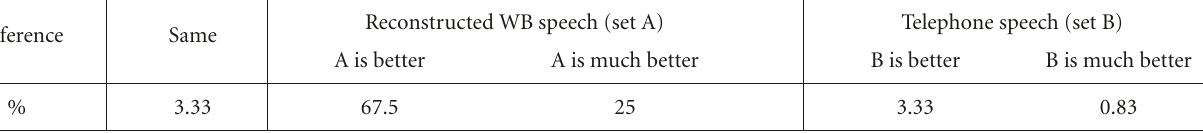
Table 2: A-B preference test for the reconstructed WB speech and the conventional telephone